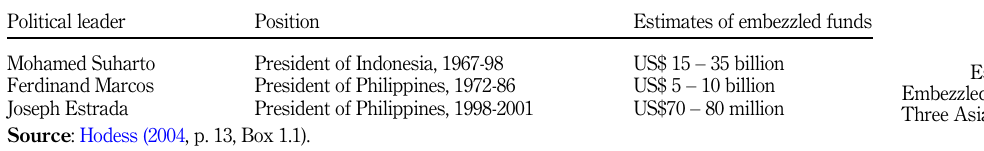
Table 2. Estimates of